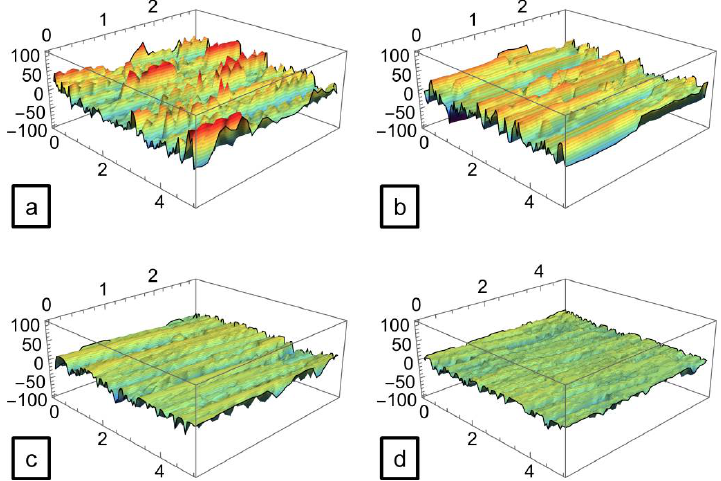
Figure 16. Propeller internal SLMed surface after ( a ) 24 h ( b ), 48 h ( c ), and 96 h ( d ) BF working time. The areal parameters quantify the previous observations. The Sa trends reported in Figure 17a highlight varying exponential decays for the analyzed zones: at 48 h, the